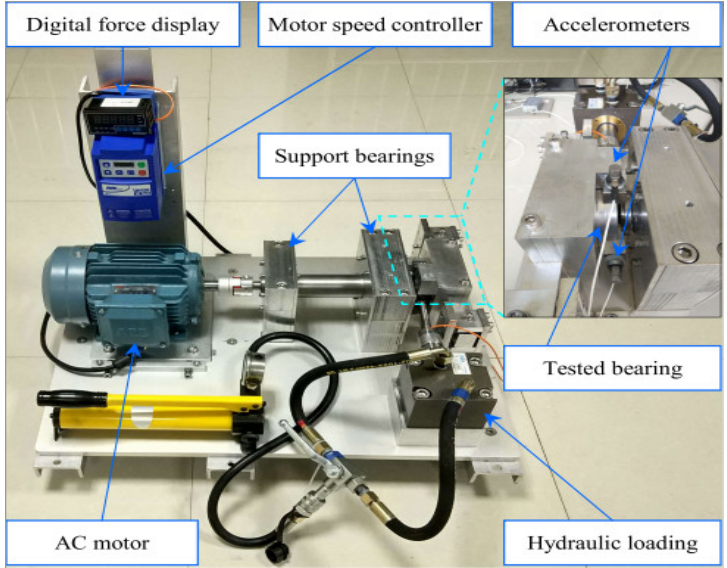
Figure 21. Bearing accelerated life test bench. The time-domain waveform and envelope spectrum of the experimental signal are shown in Figure 22.